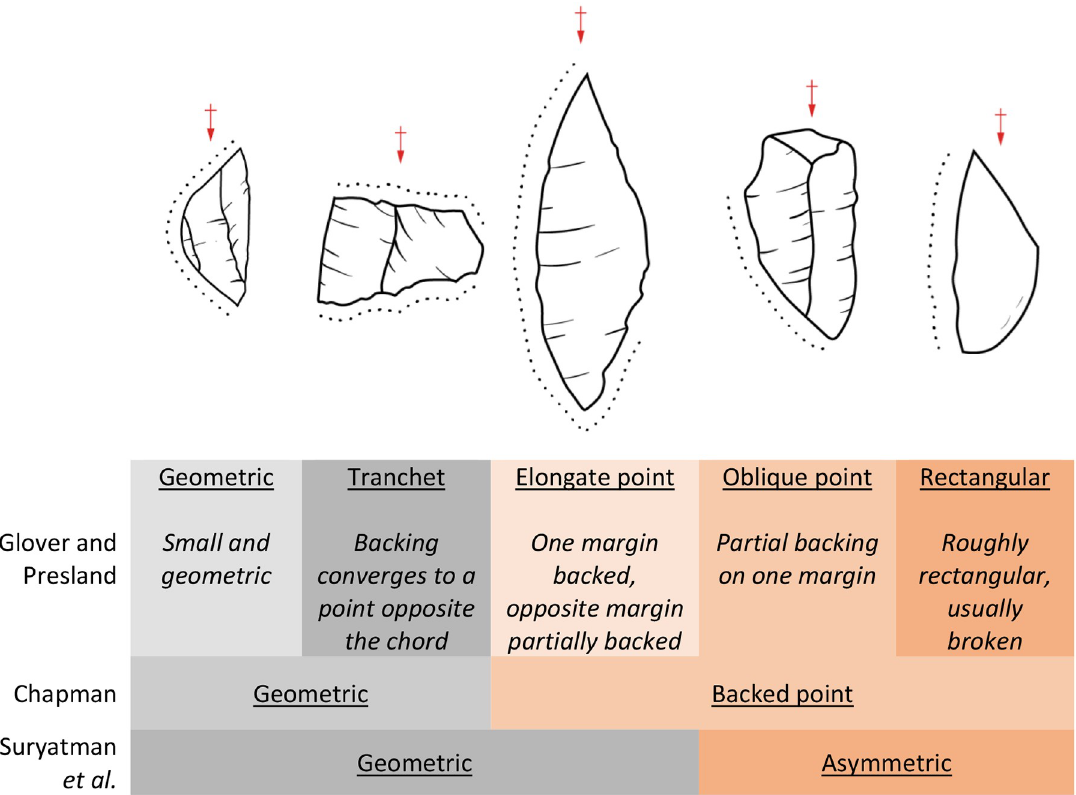
Fig 6. Different classification systems used on the backed microliths recovered from Toalean assemblages [8, 53, 85]. Red arrows indicate percussion axis. Artefact variation adopted from Glover & Presland [85 p. 19].